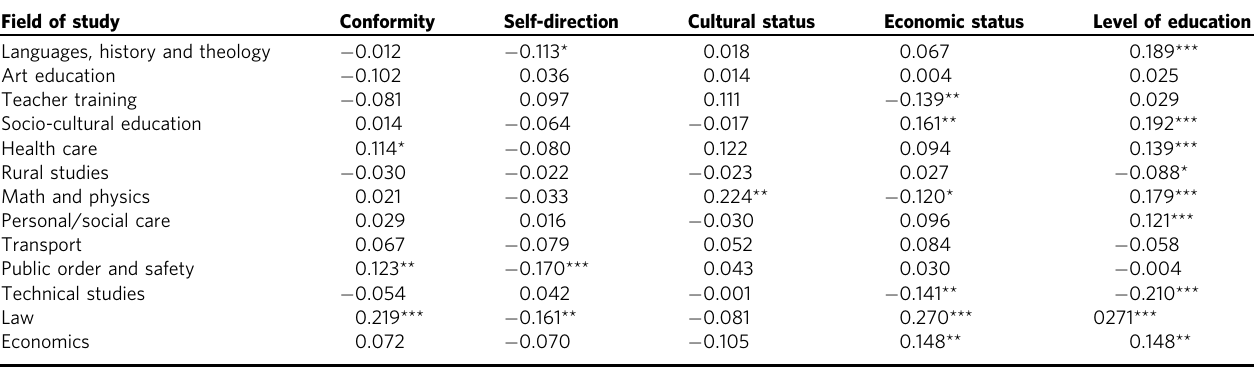
Table 5 Effects of parents ’ parenting style values, cultural and economic status, and current level of education on speci fi c fi elds of study for male